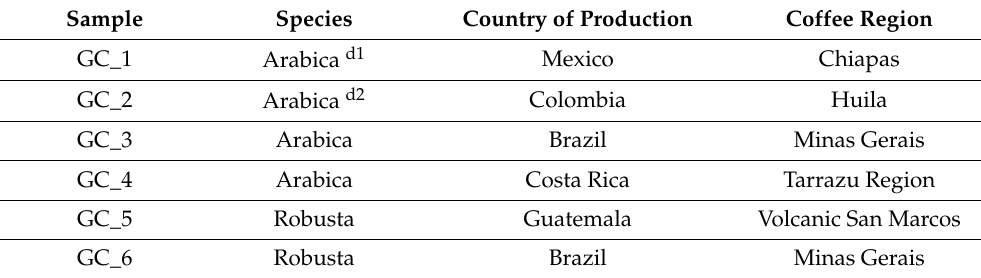
Table 1. Species and region of investigated coffee beans. Sample